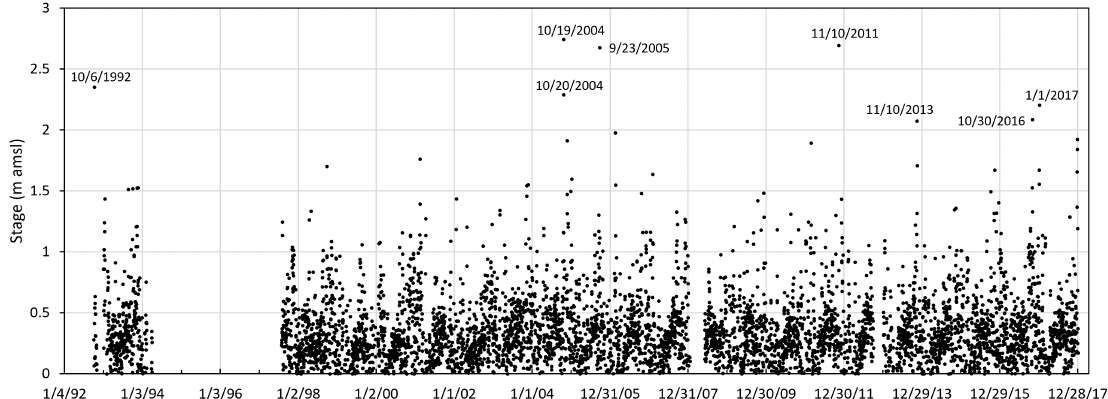
Figure 10. Magnitude of large storms (>2 m) as indicated by maximum daily water levels recorded by a NOAA tide gauge at Nome,